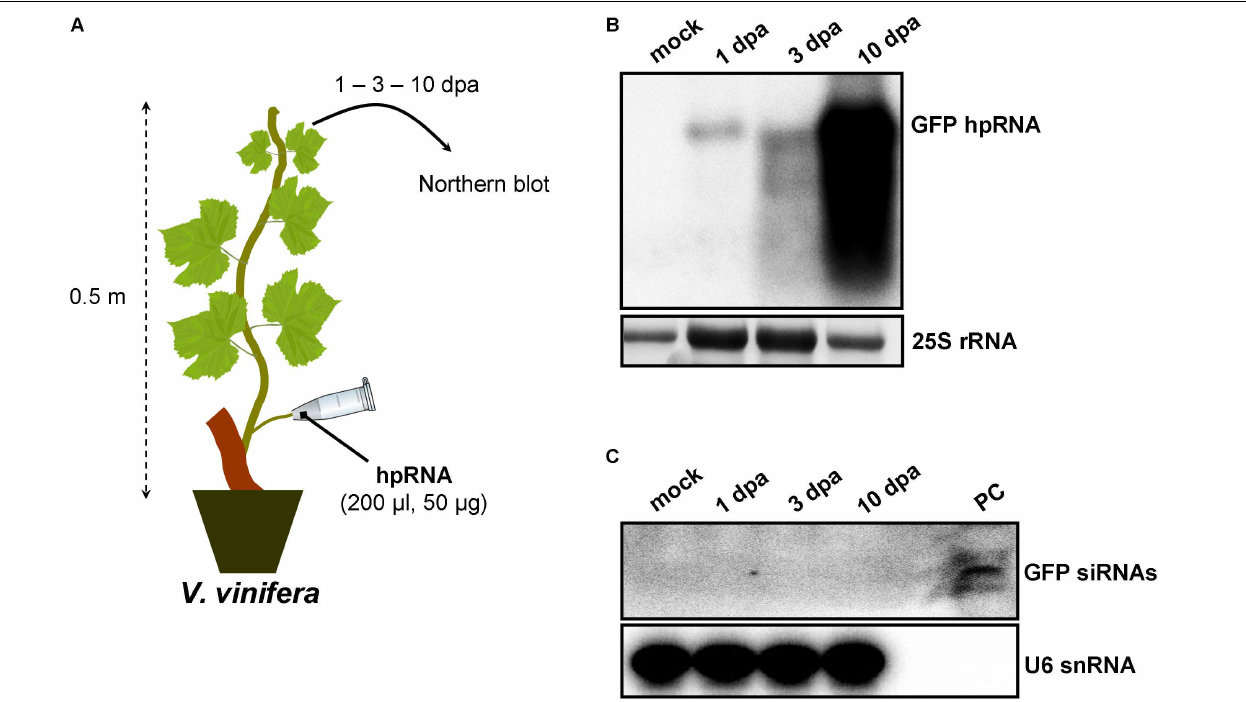
FIGURE 3 | Delivery of exogenous hpRNA (500 nt) in V. vinifera by petiole absorption. (A) Apical leaves were harvested 1, 3, and 10 dpa and total RNA was extracted. (B) Northern blot for the detection of GFP hpRNA. Total RNA (5 µ g) was analyzed in a 1.2% agarose/formaldehyde gel and the full-length GFP cDNA fragment (792 bp) was used as a hybridization probe. The ethidium bromide stained gel depicts the 25S rRNA band and serves as an RNA loading control. (C) Northern blot for the detection of GFP siRNAs. Total RNA (20 µ g) was analyzed in a 15% polyacrylamide gel and the full-length GFP cDNA fragment (792 bp) was used as a hybridization probe. As positive control (PC) in vitro synthesized 22-nt GFP siRNAs (100 ng) were included. Hybridization of the membrane with a DNA oligo detecting the U6 snRNA served as an RNA loading control.